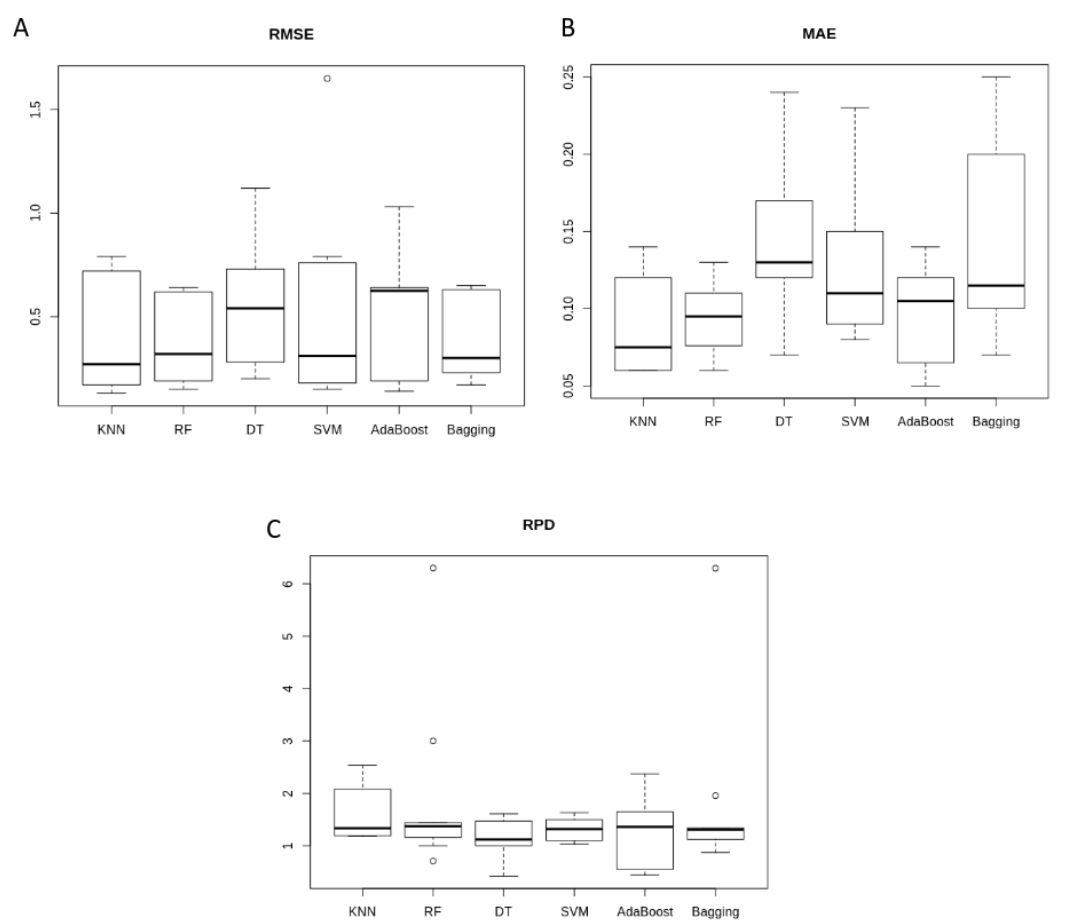
Figure 4. Evaluation of the prediction performances of the 6 machine learning models during the 10 trials. On the abscissa the model is indicated and on the ordinate the value of the statistical metrics are displayed (dimensionless): ( A ) RMSE, ( B ) MAE, and ( C )